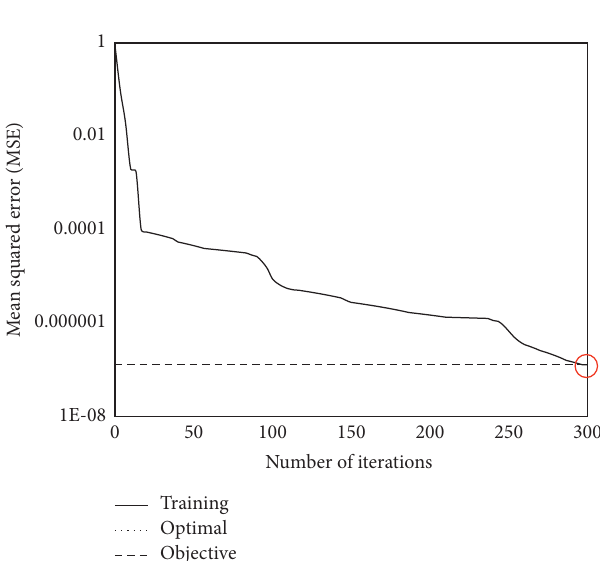
Figure 4: Change curve of training error of BP neural